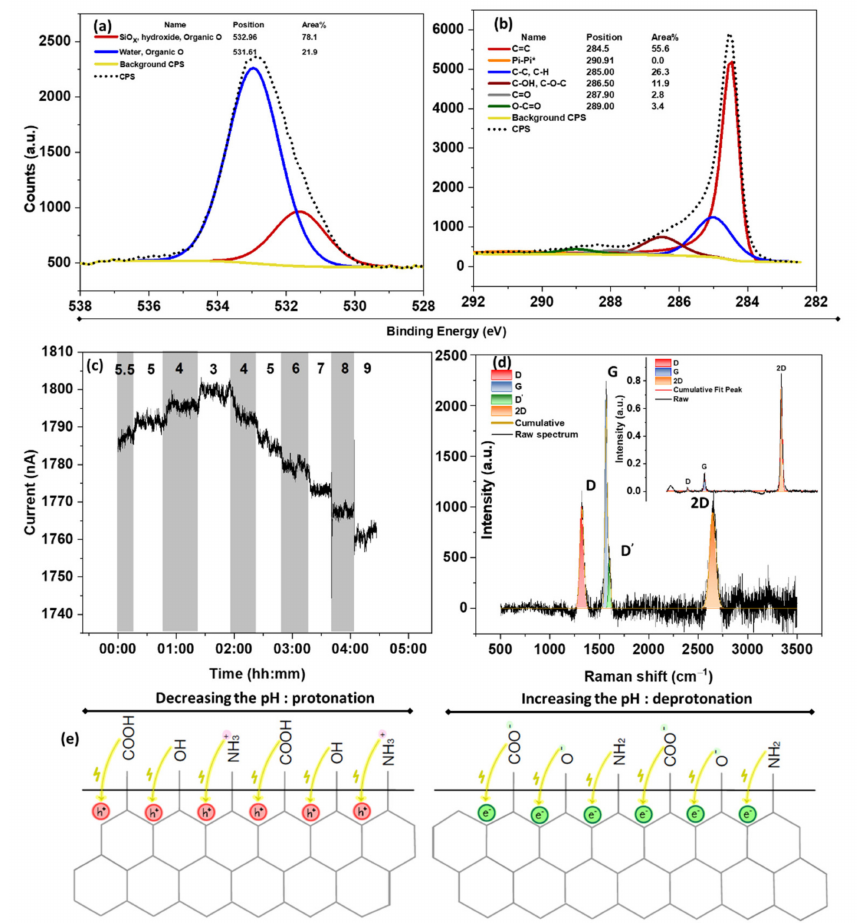
Figure 3. XPS high-resolution spectra of ( a ) O 1s and ( b ) C 1s of FLG, ( c ) pH response of FLG to pH 5.5–9 (I o = 1788 nA), ( d ) Raman of FLG deconvoluted to the main graphene characteristics of D, G, D’, and 2D (inset shows the deconvoluted Raman spectrum of SLG), and ( e ) schematic illustration of defect-induced pH response of FLG through protonation/deprotonation of carboxyl, hydroxyl, and amine